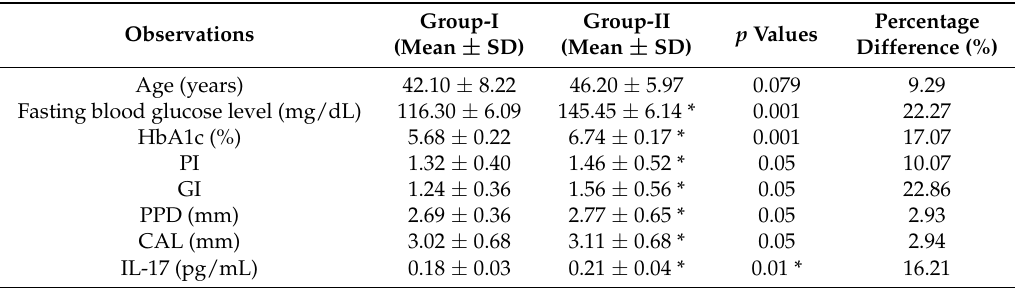
Table 3. Comparison of demographic, periodontal, and biochemical parameters between the groups before NSPT.